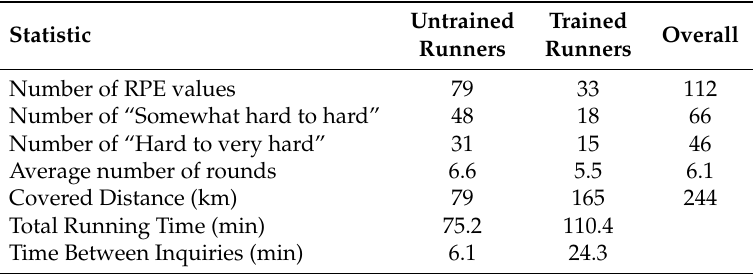
Table 1. Dataset statistics.